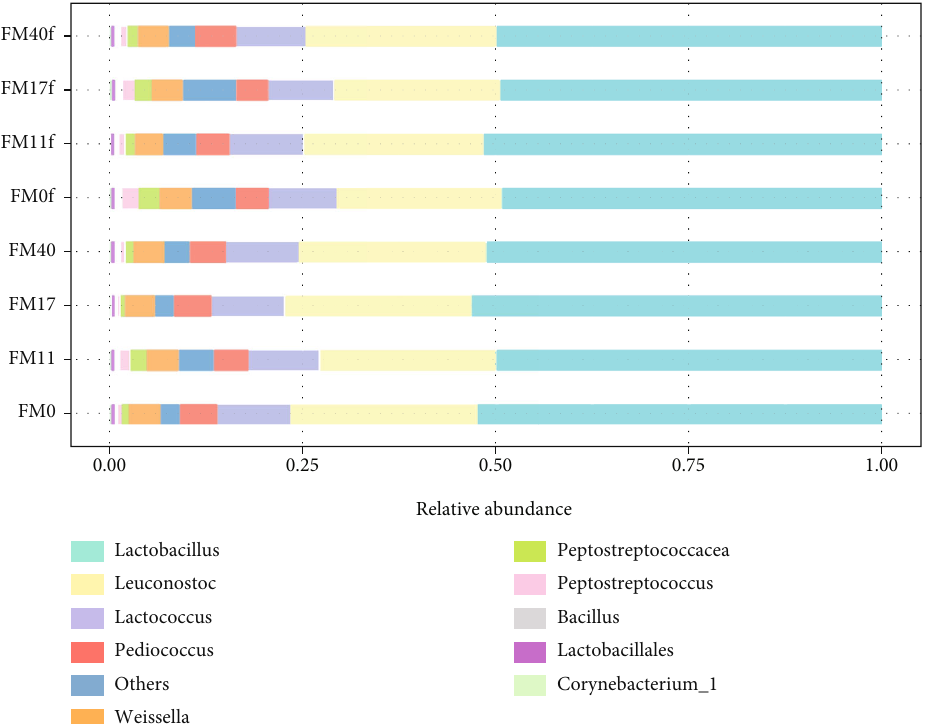
Figure 17: Results for the ten most abundant genera present in the treatments selected for these analyses, i.e., FM0, FM11, FM17, FM40, FM0f, FM11f, FM17f, and